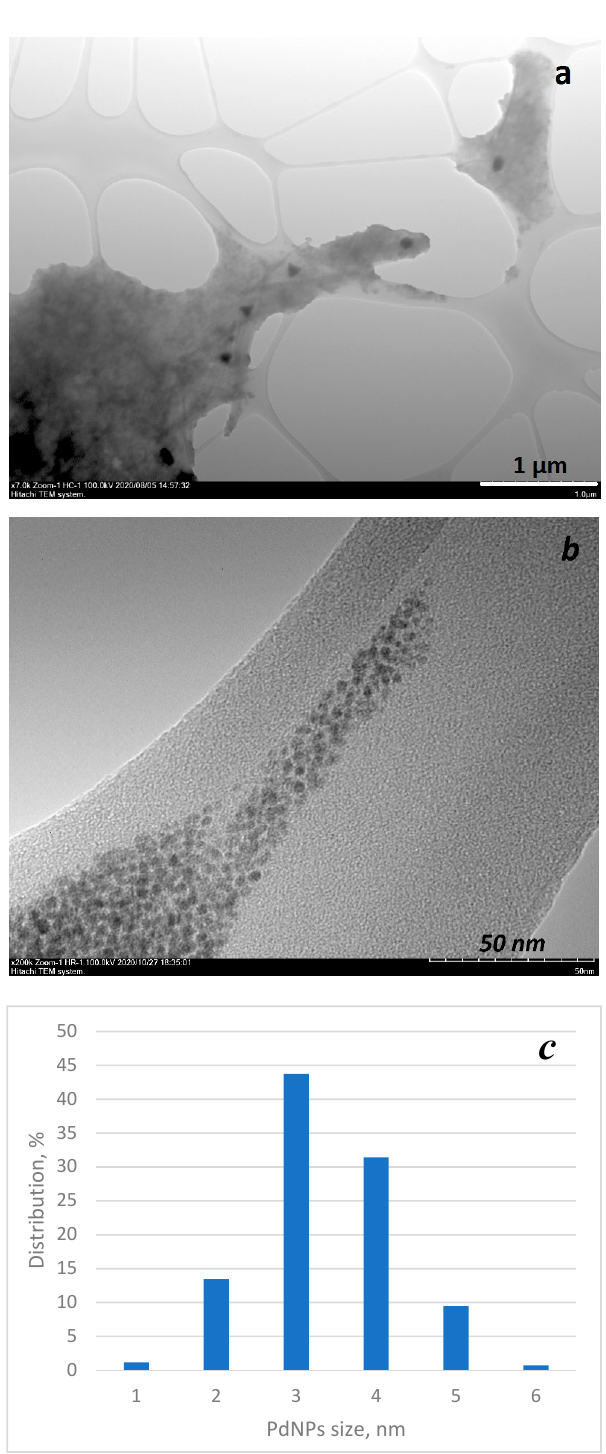
Figure 7. TEM of PdNPs using the droplet technique ( a , b ) and size distribution graph ( c ).